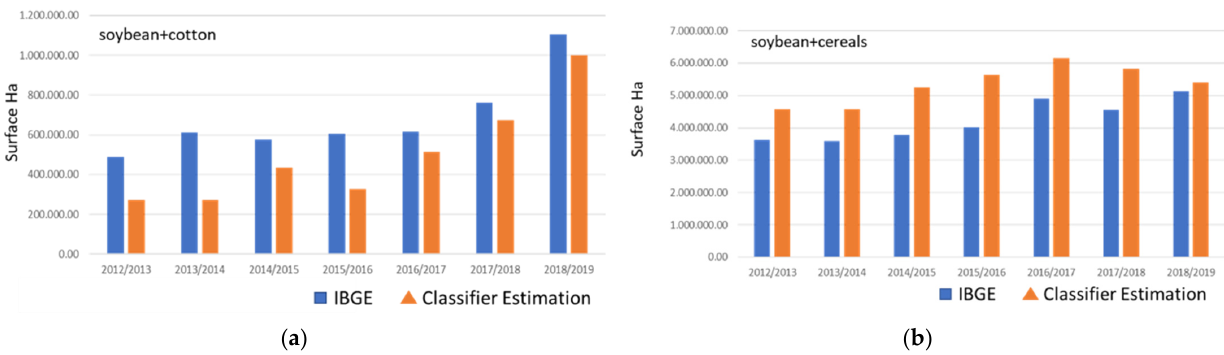
Figure 12. 2018/2019 Level 2 classification map at the Mato Grosso scale and a detailed area.